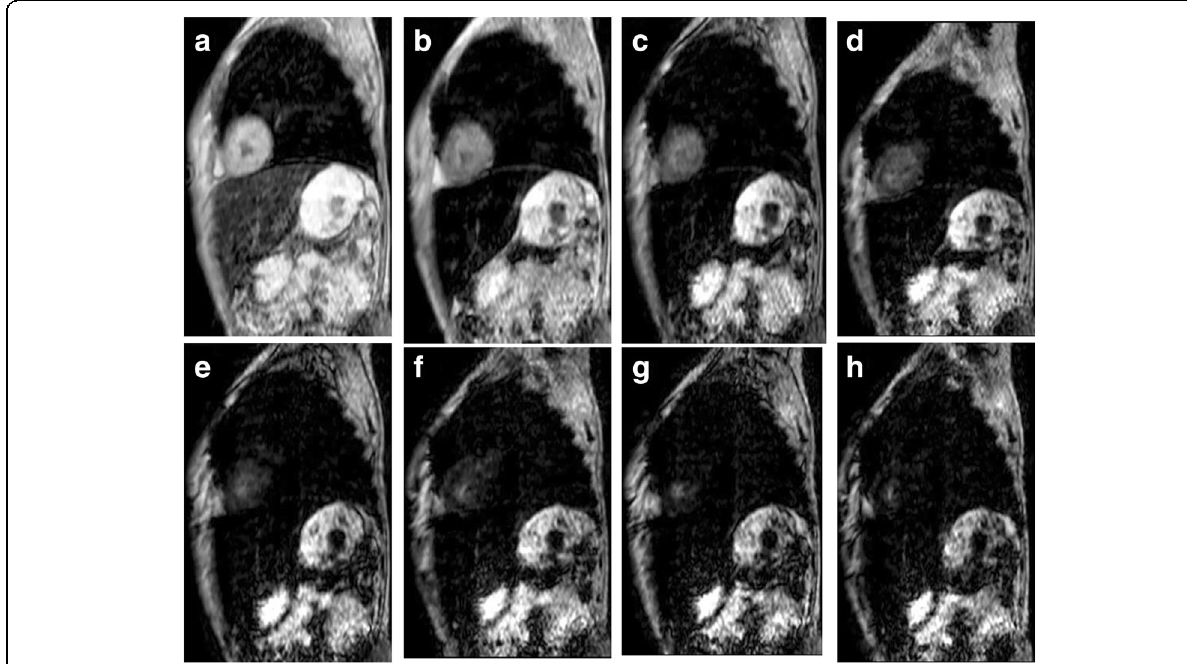
Fig. 6 Coronal images of the liver and heart at 8 different TE (1.6-18.7ms) reveal a significant decay in both hepatic and myocardial signal that increases on longer TE imaging sequences. The measured cardiac values were (T2*: value of 11.8 ms, MIC: 2.21mg/g) and hepatic values were (T2*: 1.3 ms, LIC: 25.33 mg/g). The measured serum ferritin was 3000 ng/ml. These findings are consistent with severe hepatic and moderate cardiac iron deposition. (Note: the moderate cardiac iron overload inspite of the lower level of serum ferritin and liver iron burden in this case compared to the previous case (Fig. 5) reflecting the incompetence among serum ferritin, liver iron burden and cardiac iron